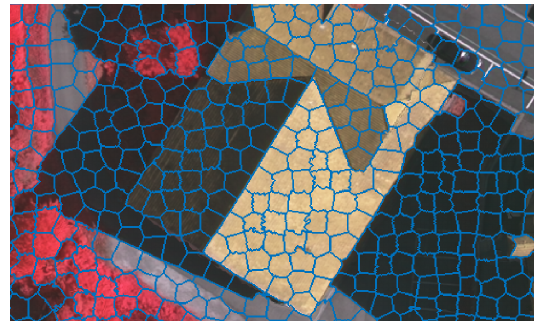
Figure 6. Detail of the SLIC segmentation result. The oversegmentation is advantageous because the segments can be grouped together later in the clustering step, but undersegmentation cannot be corrected.